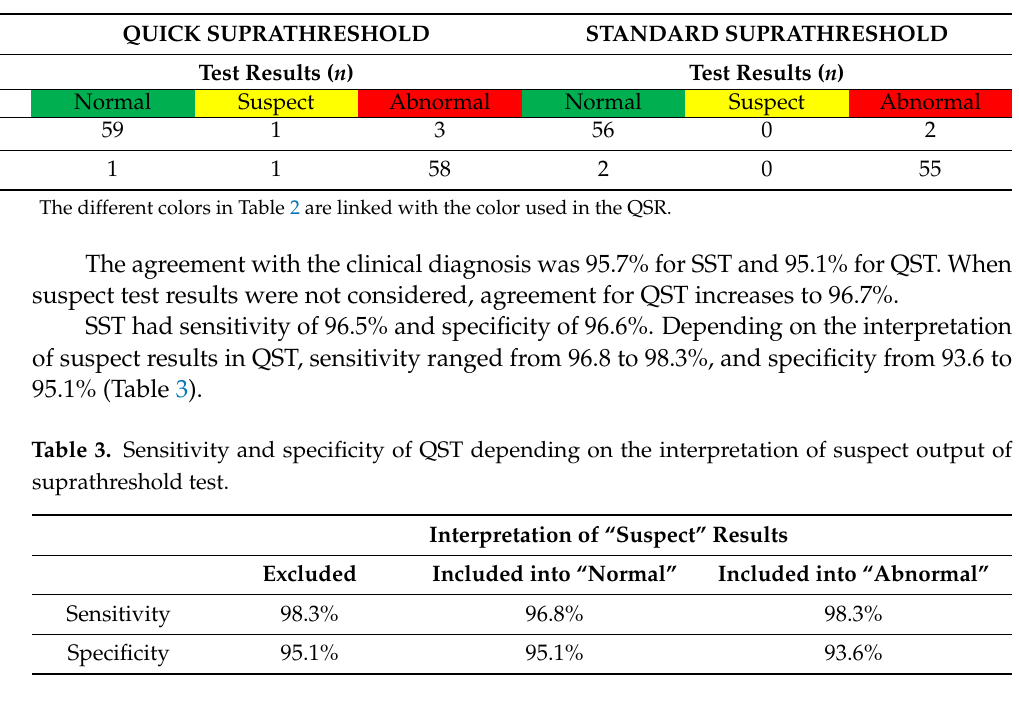
Table 2. Contingency table between clinical diagnosis and test results.